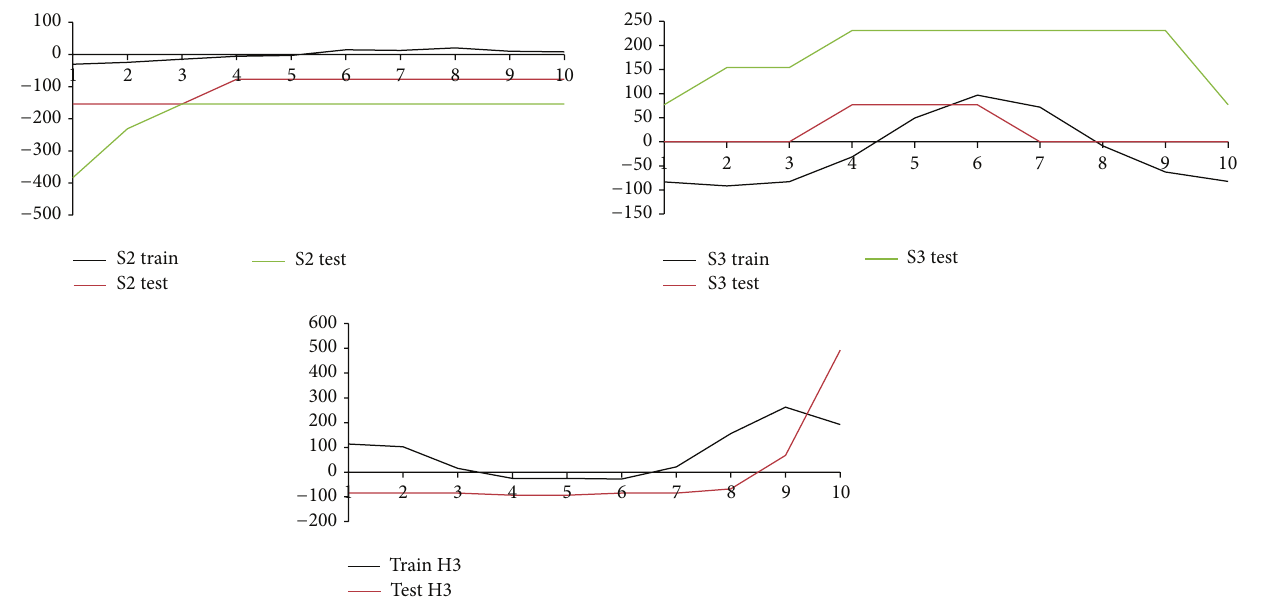
Figure 9: Training patterns, their representation in used test